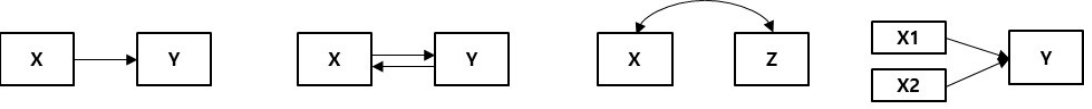
Figure 1. Path types used in a path model. ( a ) causal; ( b ) both-way causal; ( c ) correlate; ( d ) independent path.